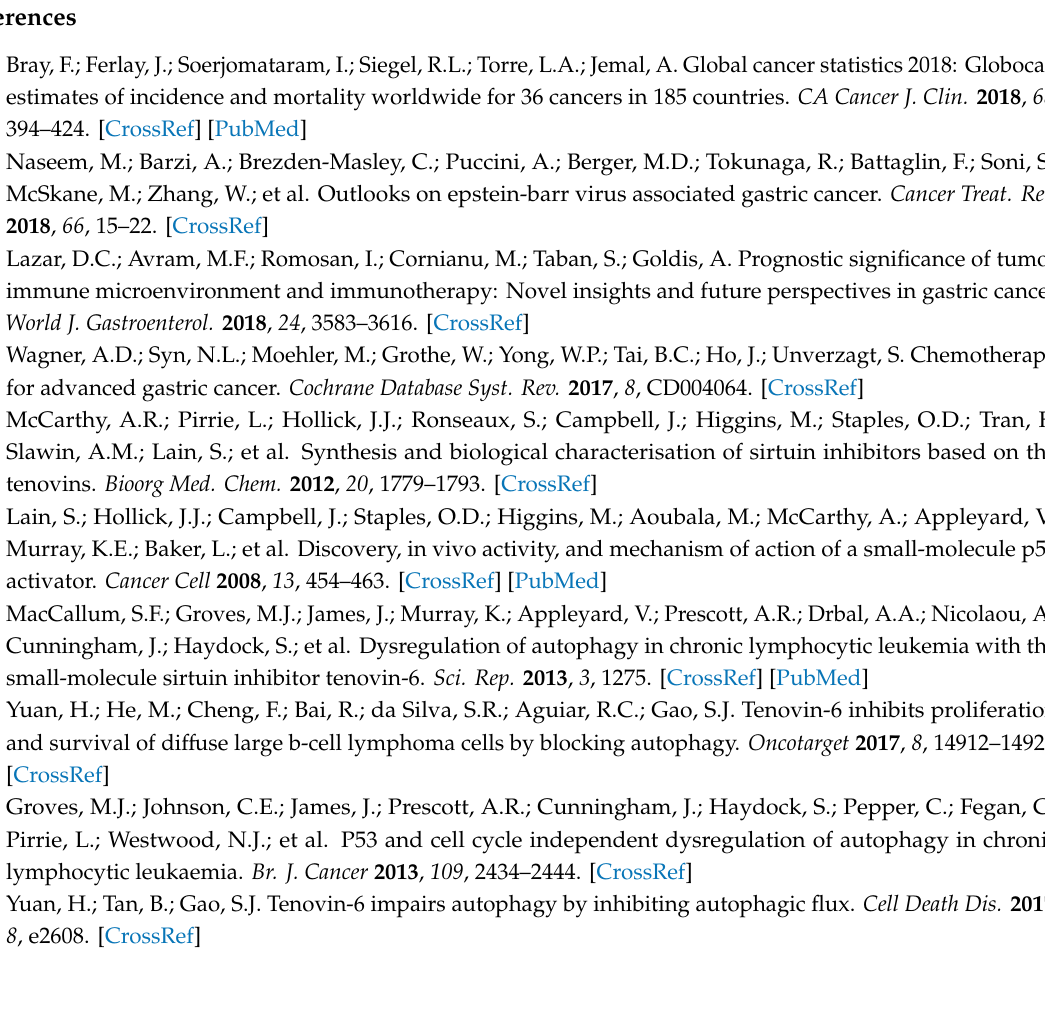
Figure S1: Original western blots for Figures 3 and